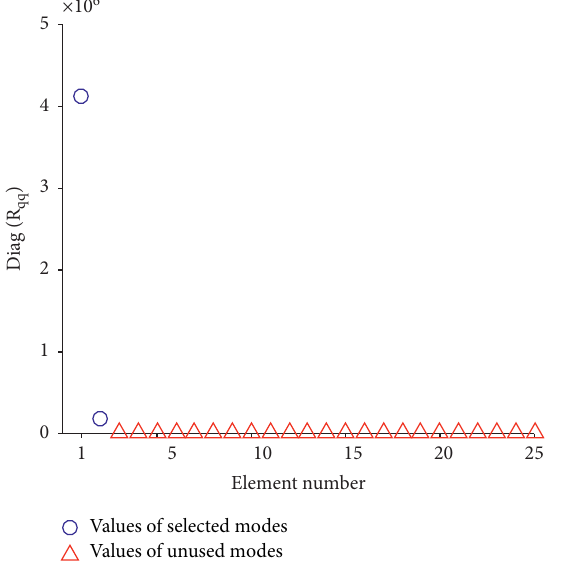
Figure 9: Diagonal element values of a cantilever beam with double damage (0.5% for the noise Table 5: Comparison of structural frequencies of the cantilever beam.